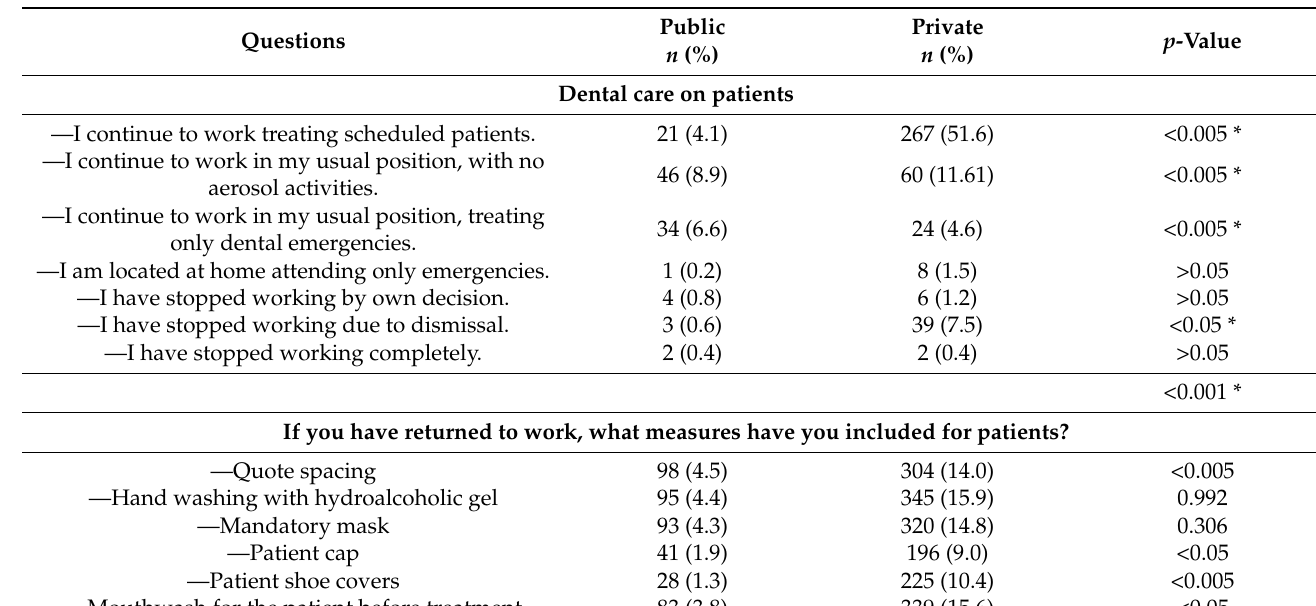
Table 3. Dental care and PPE used by hygienists after first COVID-19 peak of the pandemic.